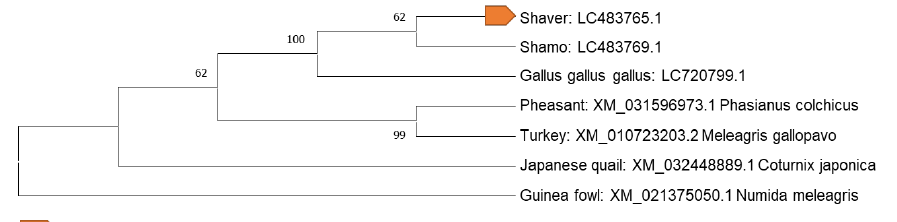
Figure 2. Phylogenetic analysis of the adrenergic receptor (ADR) gene ADR α 1A.